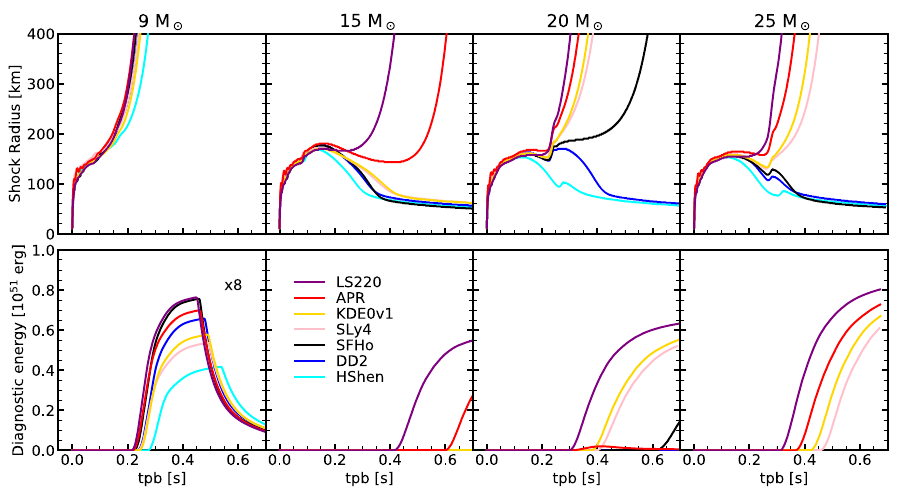
Figure 2. The upper panels display shock radius vs time for di ff erent progenitors and EOSs, while the lower panels display the diagnostic energy vs time. Notice that for the 9 M (cid:4) progenitor the diagnostic energies have been multiplied by a factor of 8 so that they could be more clearly shown on the same scale used for the other